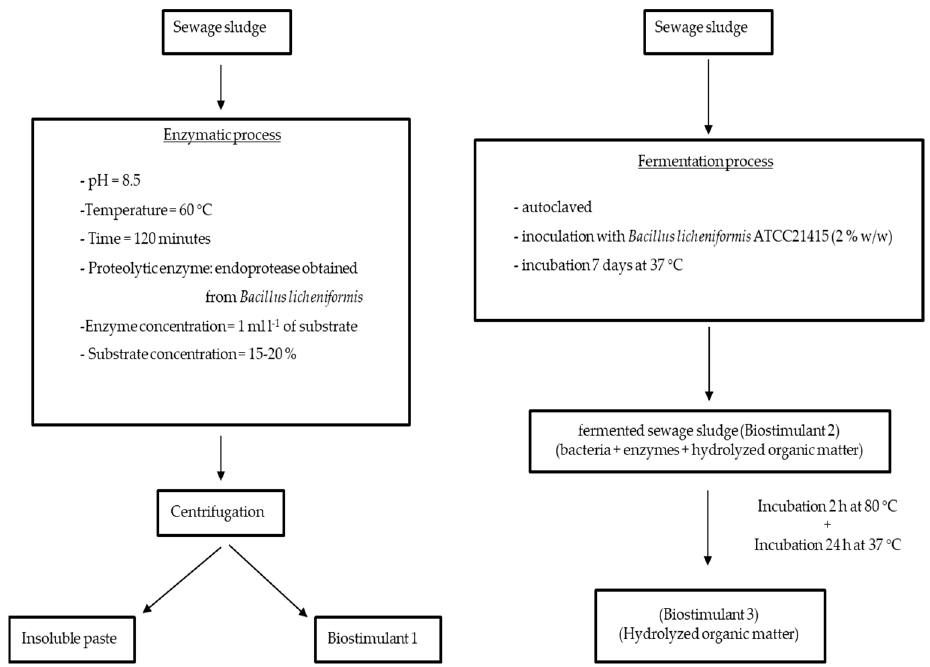
Figure 1. Scheme of the enzymatic hydrolysis and fermentation process in sewage sludge to obtain the experimental biostimulants.